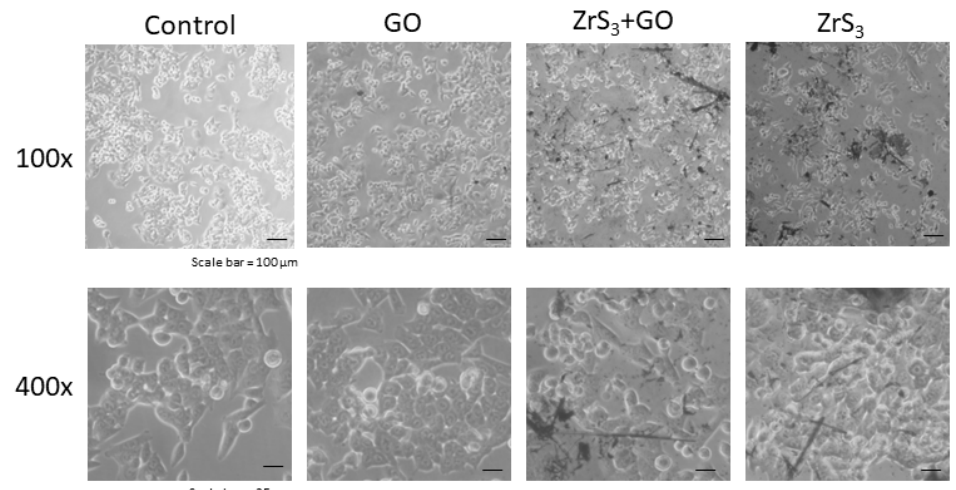
Figure 5. Microphotographs of HCT116 cells growing on nanostructured films.